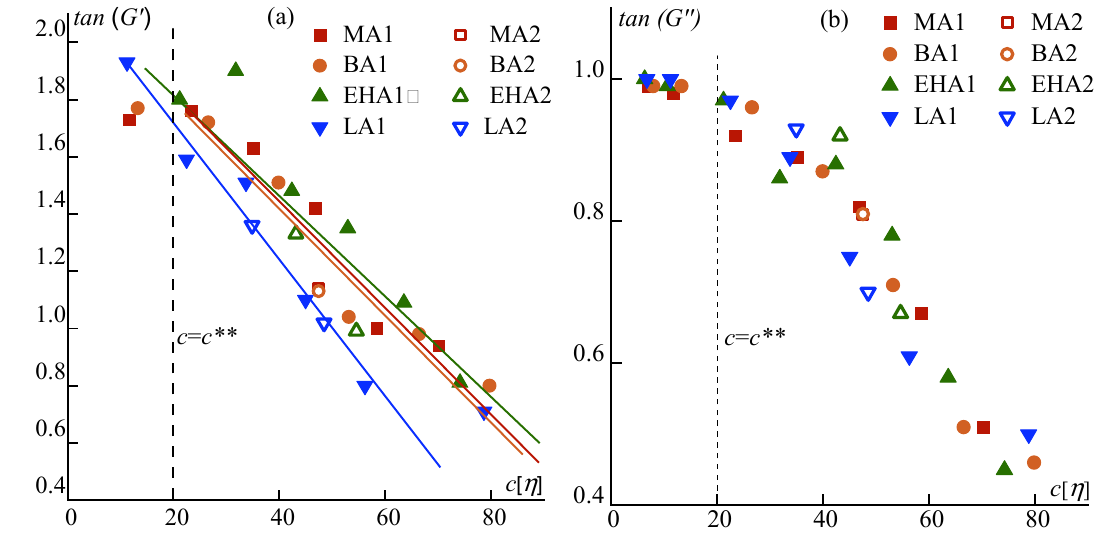
Figure 4. Dependences of the slope angle of the logarithmic frequency dependences of elastic ( a ) and loss ( b ) moduli in the terminal zone at 25 °C on the dimensionless parameter c [ η ] for PAN terpolymer solutions.